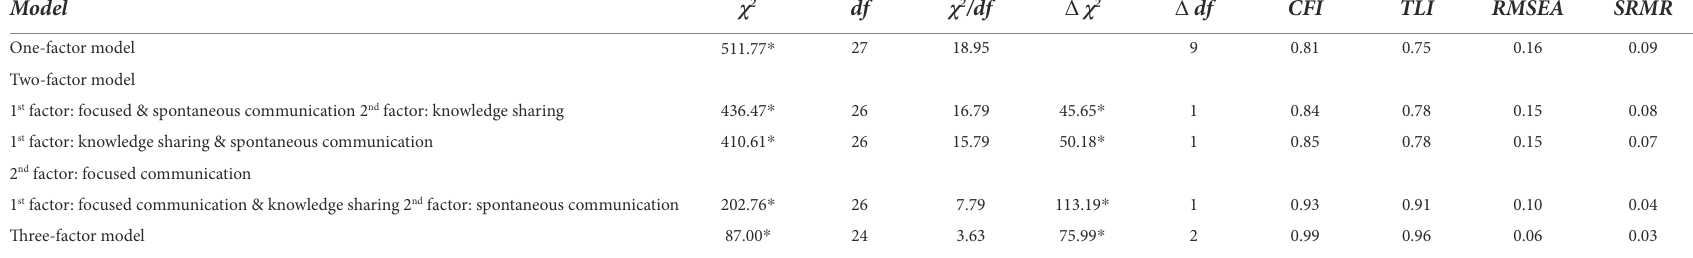
TABLE 5 Study 4: Confirmatory factor analysis on the team level. Model